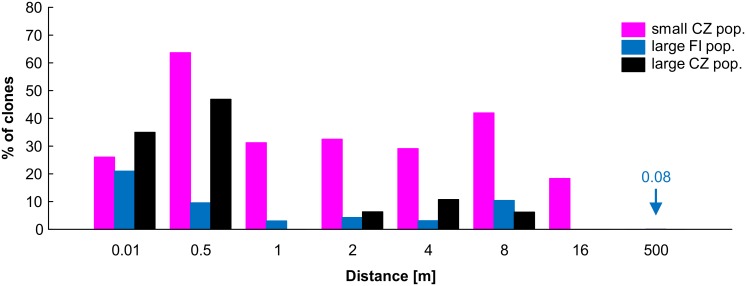
Percentages of clones within distance classes.Number of all pairwise comparisons in each distance: 0.01 m– 58, 96, 24; 0.5 m– 54, 211, 35; 1 m– 43, 166, 30; 2 m– 31, 274, 39; 4 m– 75, 321, 39; 8 m– 36, 266, 48; 16 m– 87, 168, 48; 500 m– 270, 6558, 948 for small CZ pop., large FI pop., large CZ pop., respectively. Long distances among clones (> 16 m) were found only in all FI populations (blue arrow).